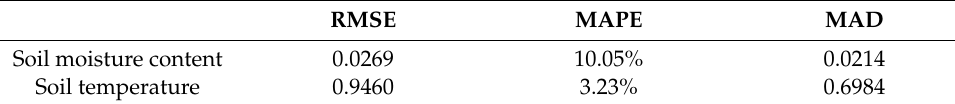
Table 5. Model performance evaluation calculation table.